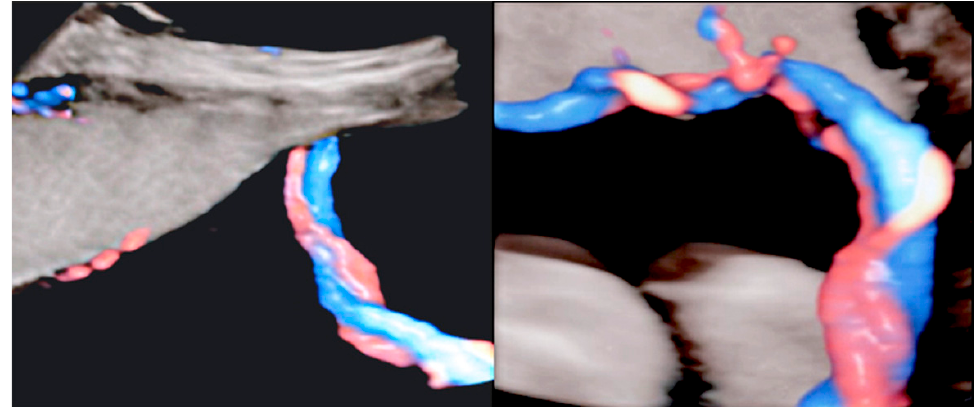
Figure 23. Marginal insertion of the umbilical cord using HD-Flow™ Doppler ultrasound.